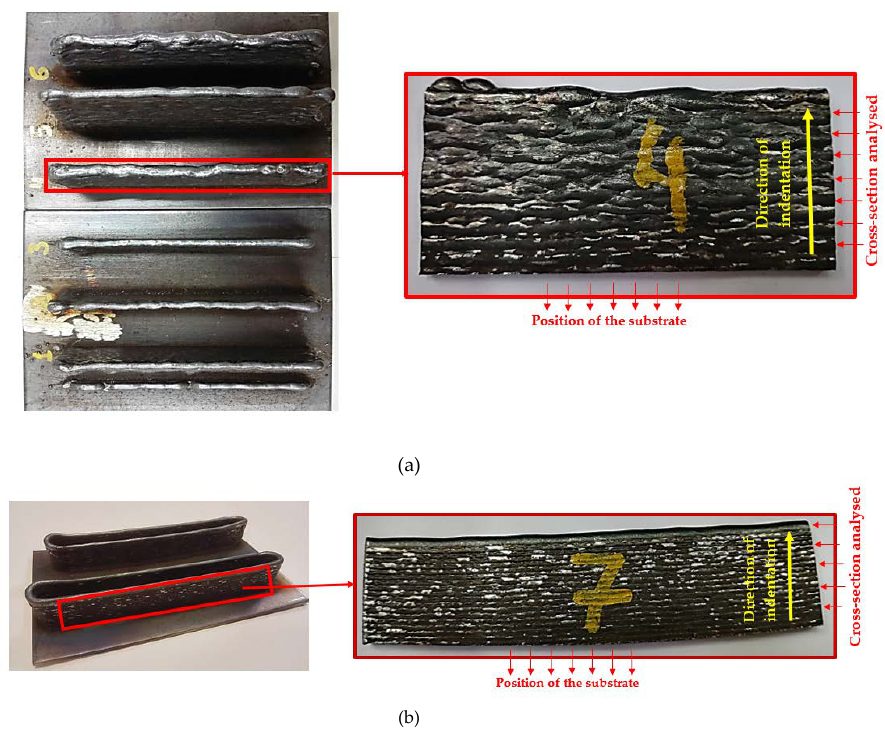
Figure 4. Location of the cross-section analyzed and the position of the substrate: ( a ) Samples nº 1 to n 6, showing the location of the cross-section analyzed with sample nº 4; ( b ) Tool path during the deposition process in sample nº 7 and the final sample obtained.